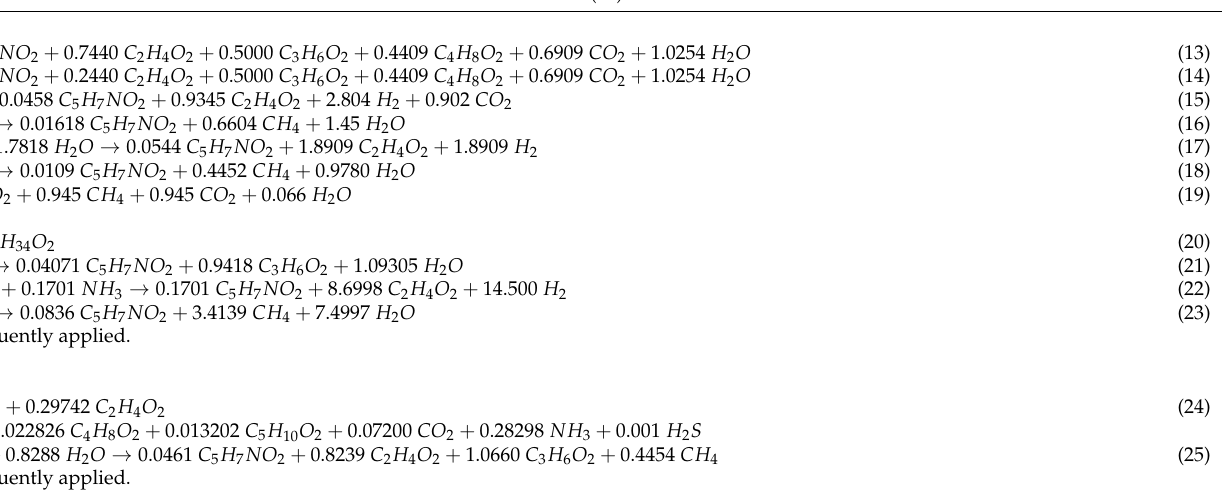
Extent of the hydrolysis reaction of starch to glucose in the steam explosion step was assumed as 100%. Cellulose and hemicellulose hydrolysis was assumed as 19.4% and 90%, respectively [60]. Yield of reducing sugars (mainly glucose and xylose) in saccharification was assumed as 82% [90]. Reaction extent from starch to dextrin was 84.54 %, from dextrin to maltose was 63.27 %, and from dextrin to glucose was 36.72 % [8]. Reaction extent in saccharification was assumed as 80%